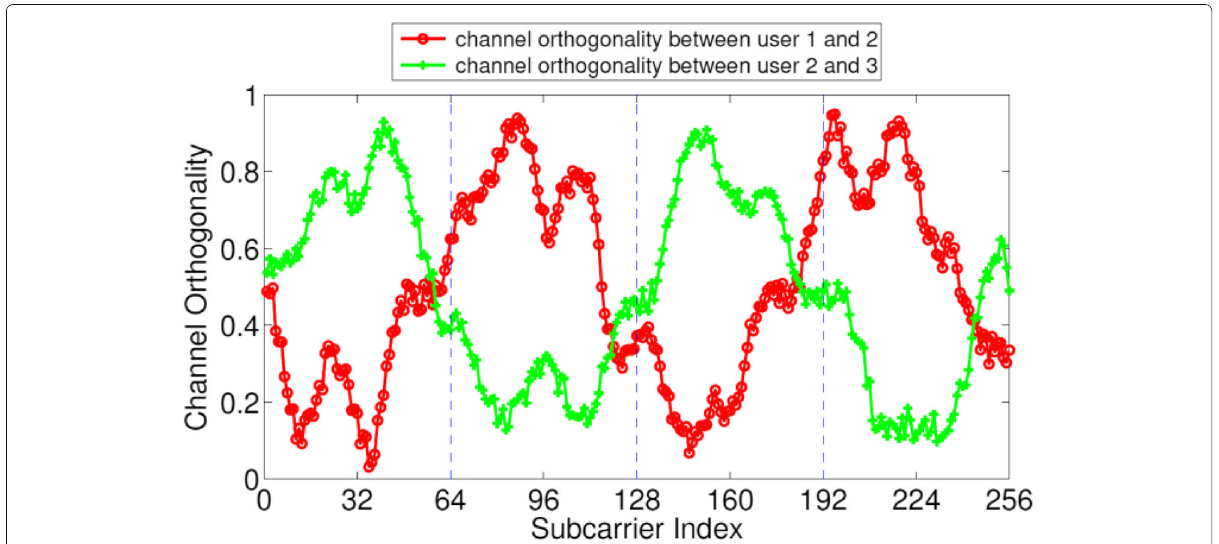
Fig. 4 Demonstration of selectivity-aware channel division on 5.2 GHz